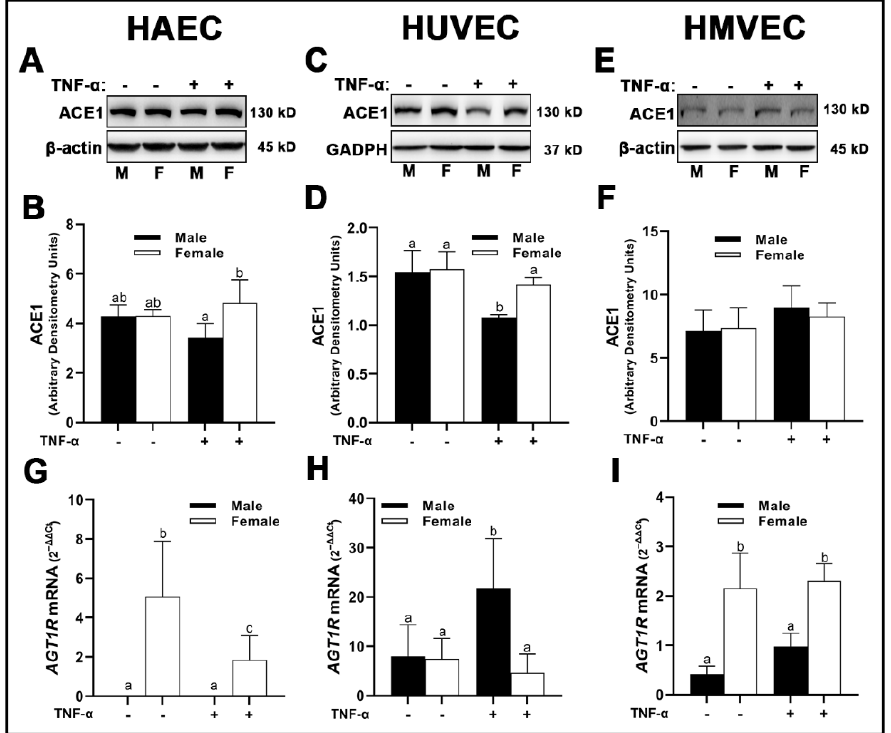
Figure 2. Expression of pathological RAS components in male and female endothelial cells. HAECs, HUVECs and HMVECs were cultured in starvation medium at ~80% confluency for 24 h with or without TNF- α (20 ng/mL). Protein expression of ACE1 ( A –F) were determined by Western blot. Quantification was performed using Image Lab (Bio-Rad Laboratories, Inc.). Protein was normalized to respective control bands ( β -actin or GAPDH). Gene expression of AT 1 R ( G – I ) were determined with qPCR. Genes of interest were normalized to housekeeping gene cyclophilin. Data are expressed as mean ± SD from 3–6 experiments. Data were statistically analyzed with one-way ANOVA followed by Tukey post hoc multiple comparison analysis between groups. Values that do not share the same letter are significantly different from each other ( p ≤